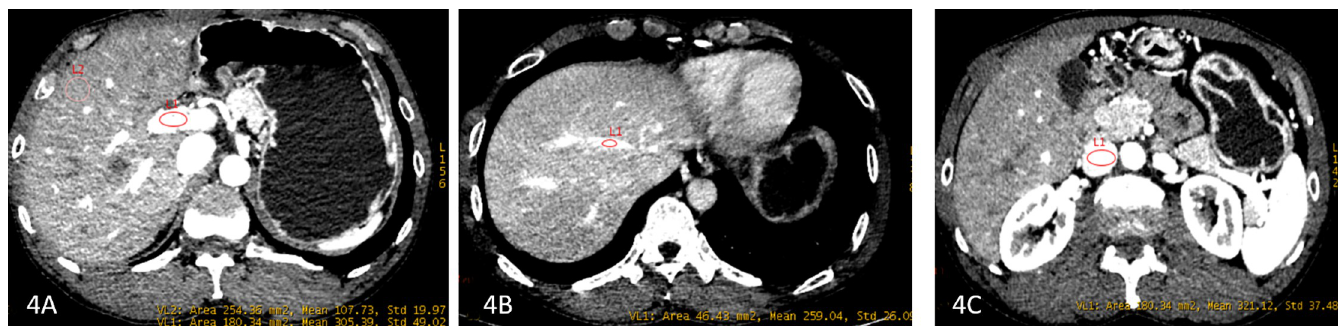
Fig 4. The CNR values of PV trunk, HV, IVC and hepatic parenchyma. Female, 57 years old, imaging diagnosis of BCS (HV type).Fig 4A–4C, Axial images, showed PV trunk, HV and IVC. The CNR values of PV trunk, HV, IVC and hepatic parenchyma were: 12.02, 4.09, 4.89, 5.64 and 1.61 respectively.